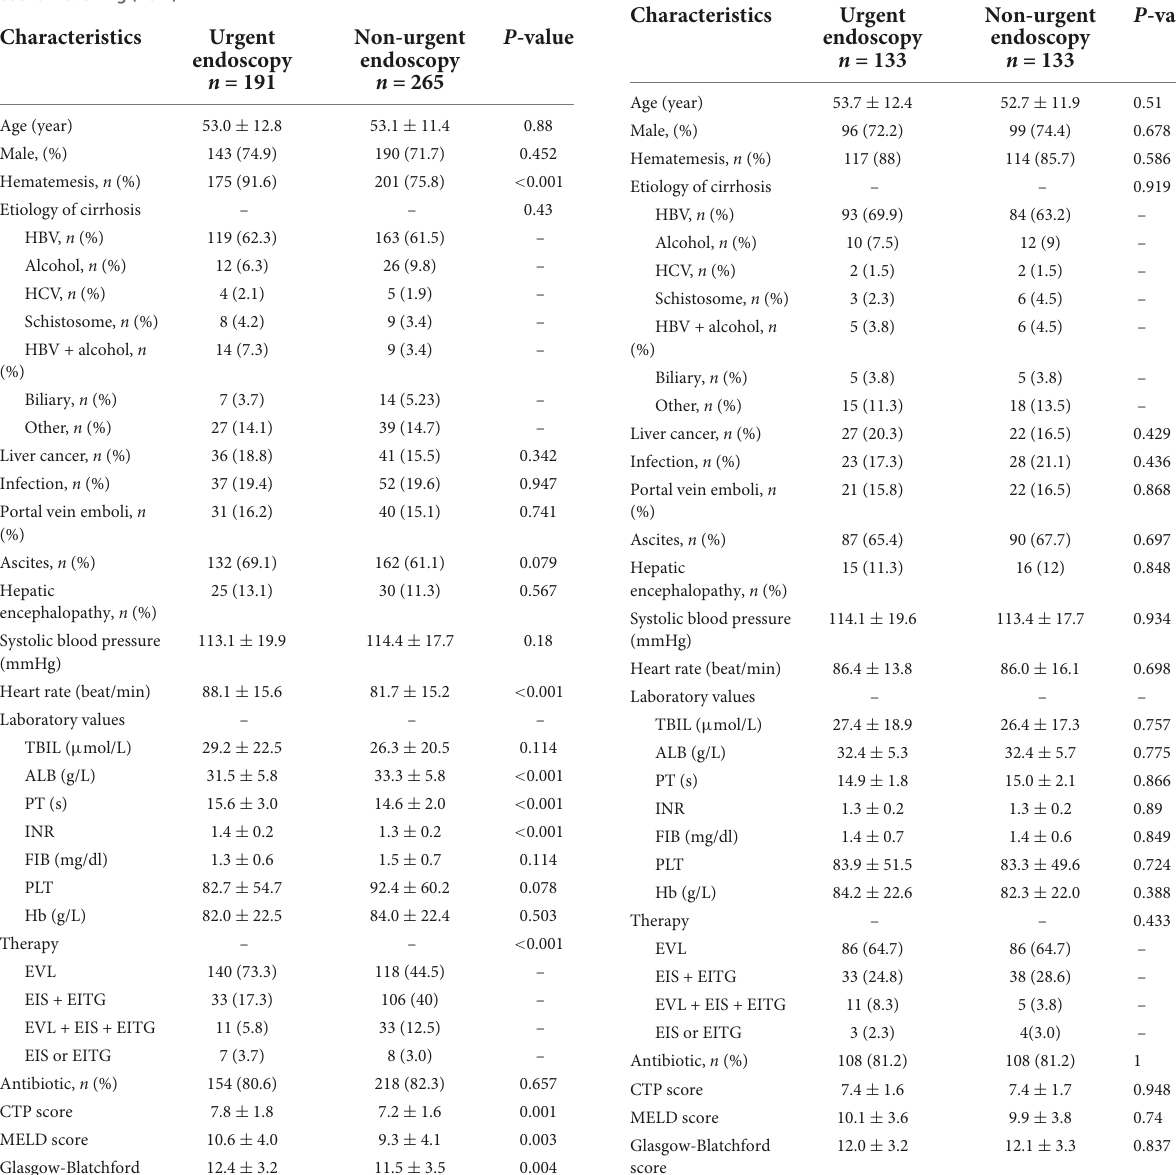
TABLE 1 Baseline characteristics of patients in urgent ( ≤ 12 h) and non-urgent ( > 12 h) endoscopy before propensity score matching (PSM).